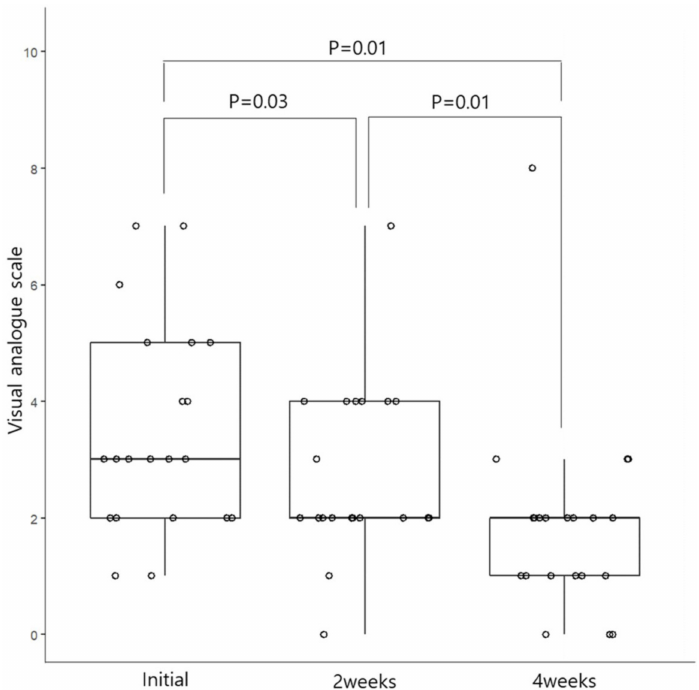
Figure 1. Changes in the visual analog scale score at 2 and 4 weeks before and after phototherapy among patients with allergic rhinitis.